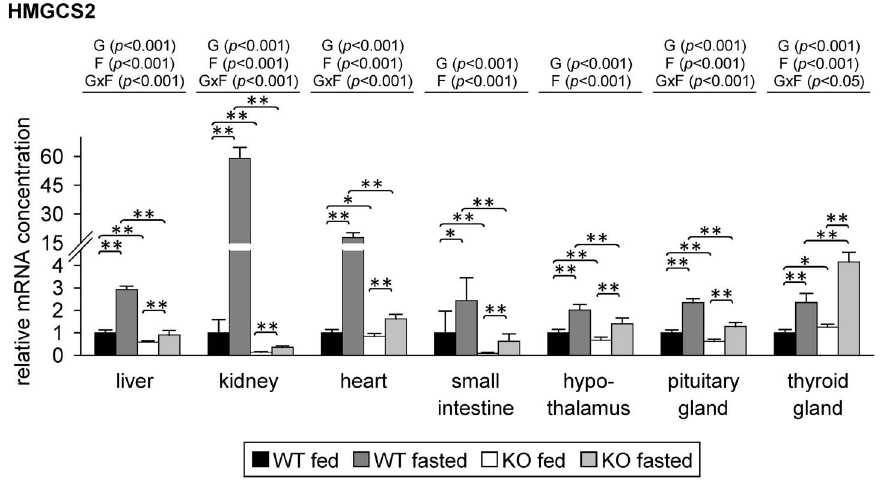
Figure 2. Relative mRNA concentrations of 3-hydroxy-3-methylglutaryl-coenzyme A synthase (HMGCS)-2 in mouse tissues in response to fasting and PPAR a . Values represent means 6 SD of relative mRNA concentrations of wildtype (WT) and PPAR a knockout (KO) mice that were fed ad libitum or fasted for 48 h (n=16 for liver, kidney, heart, small intestine and hypothalamus; n=8 for pituitary gland, n=6 for thyroid gland). Data were analyzed by two-way ANOVA. Classification factors were genotype, fasting, and the interaction between both factors. P -values revealed by two-way ANOVA are noted above the figures. Individual means of the treatment groups were compared by Tukey’s test in case of variance homogeneity. In case of variance heterogeneity, as revealed by Levene’s test, individual means were compared by Games Howell test. Horizontal brackets represent differences between groups in post-hoc comparison (** p , 0.001, * p , 0.05).